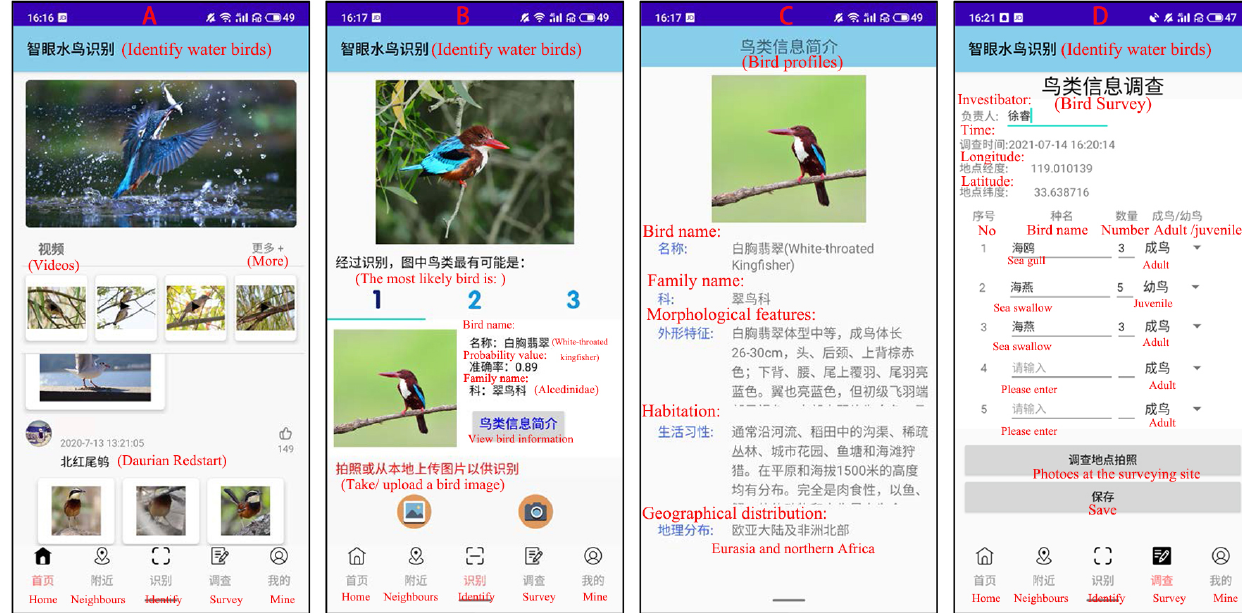
Figure 3. Some screenshots of the EyeBirds app interface. ( A ) App main interface. ( B ) Top 3 predicted results. ( C ) Bird information for the top 1 prediction. ( D ) Bird field survey. The English explanations of the morphological features and habits of white-throated kingfisher in ( C ) are as follows: (1) This species is medium-sized, 26-30cm in length for adults. Its feathers of head, nape and upper back are brownish-red, and lower back, and upper tail and tal feathers are bright blue. (2) It often hunts along rivers, rice ditches or water bodies in jungles and urban gardens, fishponds and beaches. It is a carnivore that feeds mainly on fish and is found on the plains and at altitudes of up to 1500